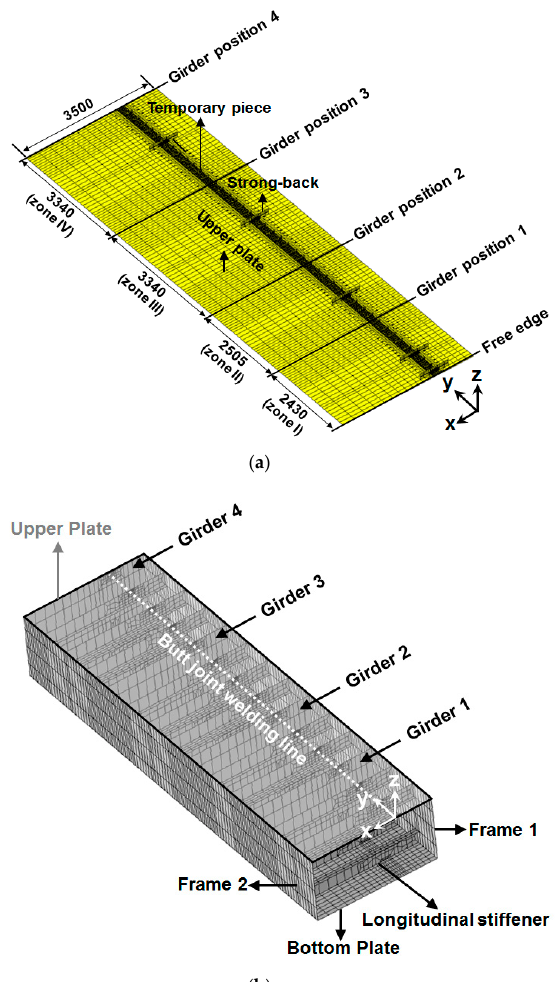
Figure 20. Finite elements model of panel block: ( a ) upper plate and pieces and ( b ) whole model.